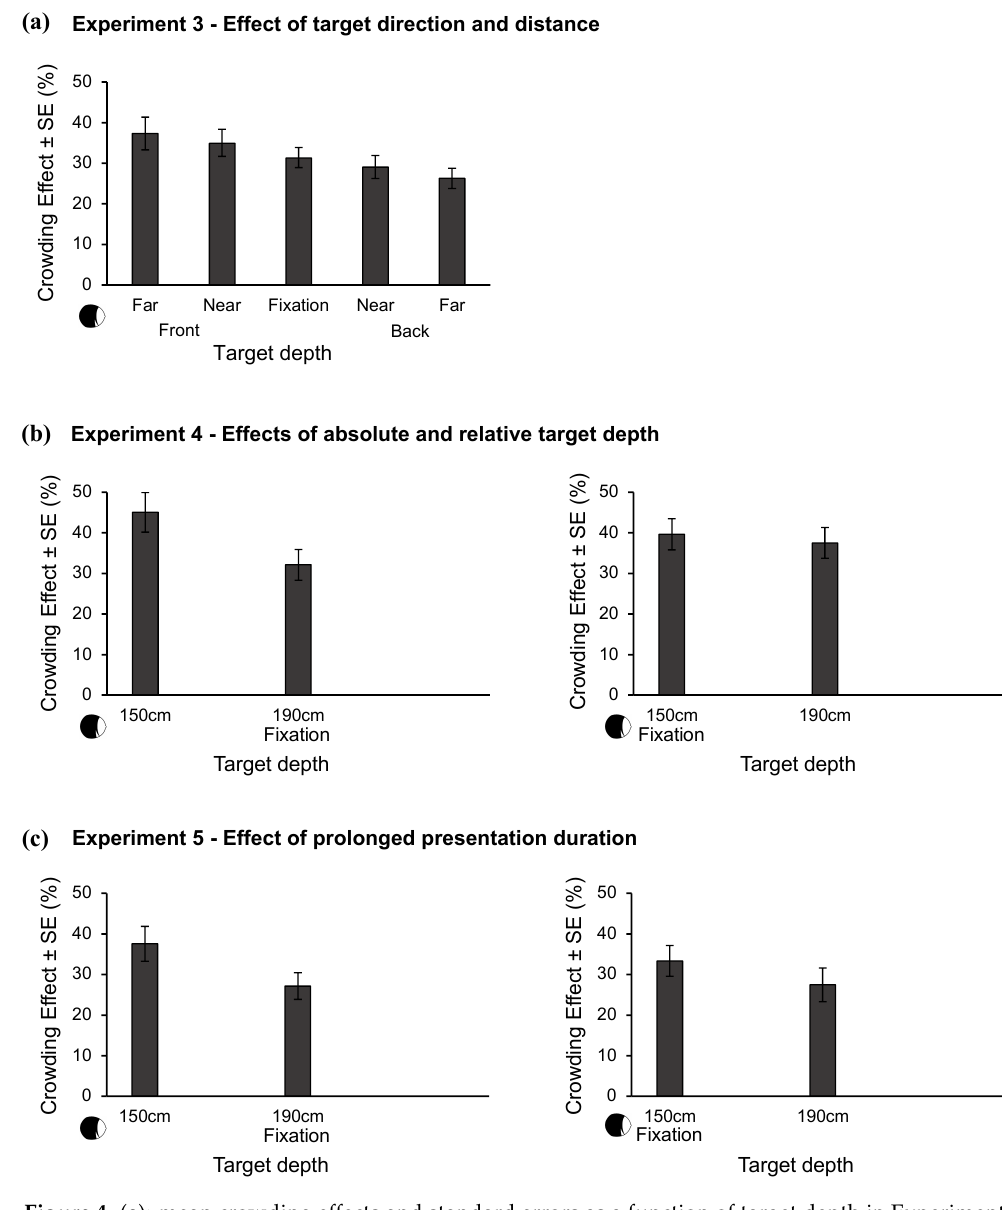
Figure 4. ( a ): mean crowding effects and standard errors as a function of target depth in Experiment 3. ( b ): mean crowding effects and standard errors as a function of target depth in Experiment 4 for fixation at 190 cm (left; as in Experiment 3) and for fixation at 150 cm (right). ( c ): mean crowding effects and standard errors as a function of target depth in Experiment 5 for fixation at 190 cm (left; as in Experiment 3) and for fixation at 150 cm (right). In all Experiments, flankers were on the fixated depth, while target depth was varied. The x-axis of the plots are aligned to facilitate comparison of result patterns. Observer pictograms on the left side of the x-axis illustrate that data points from left to right are ordered with regard to increased distance from the observer; x-labels refer to the fixation-centered reference labeling used throughout the